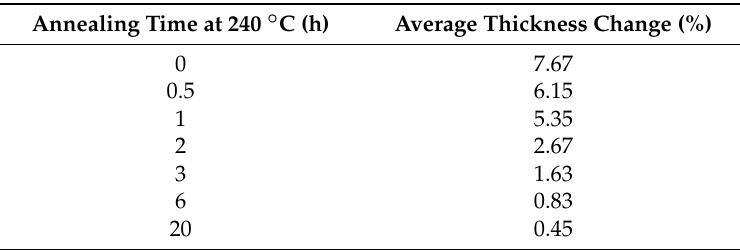
Table 3. Thickness changes measured on blank laminates after IR heating as a function of the annealing time at 240 ◦